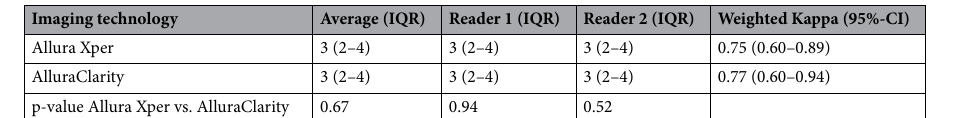
Table 4. DSA image quality of adrenal venograms. Data presented as mean with interquartile range (IQR) or with 95% confidence intervals (CI); * = significant. Image quality was graded as follows: 1, poor; 4, excellent.